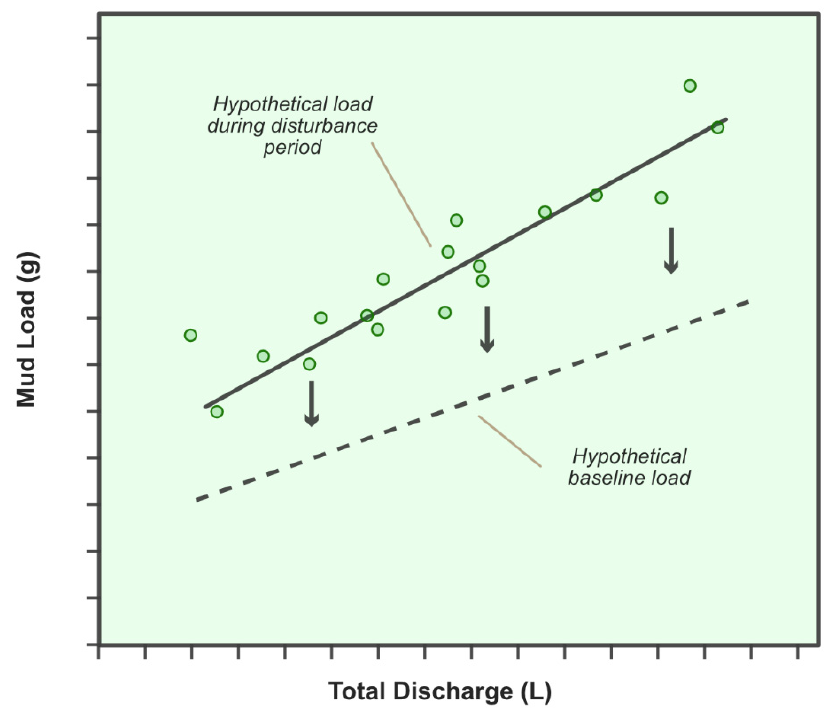
Figure 2. Diagram showing schematic system change after catchment disturbance with a higher mud load recorded in total discharge for each rainfall event.